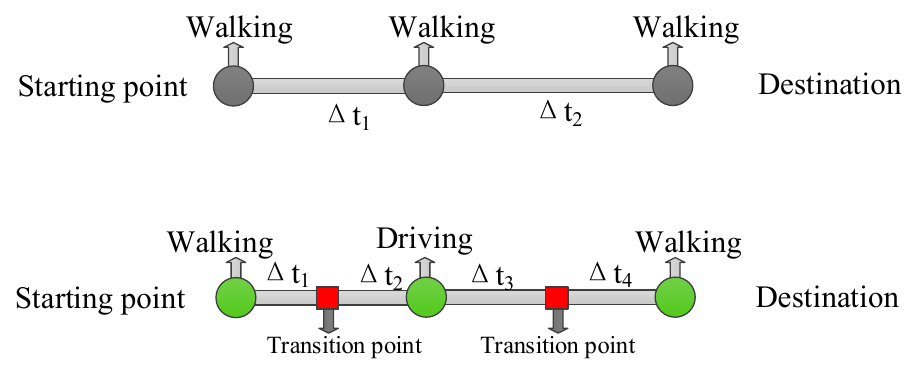
Figure 2. Analysis of the use of transportation mode of moving objects.